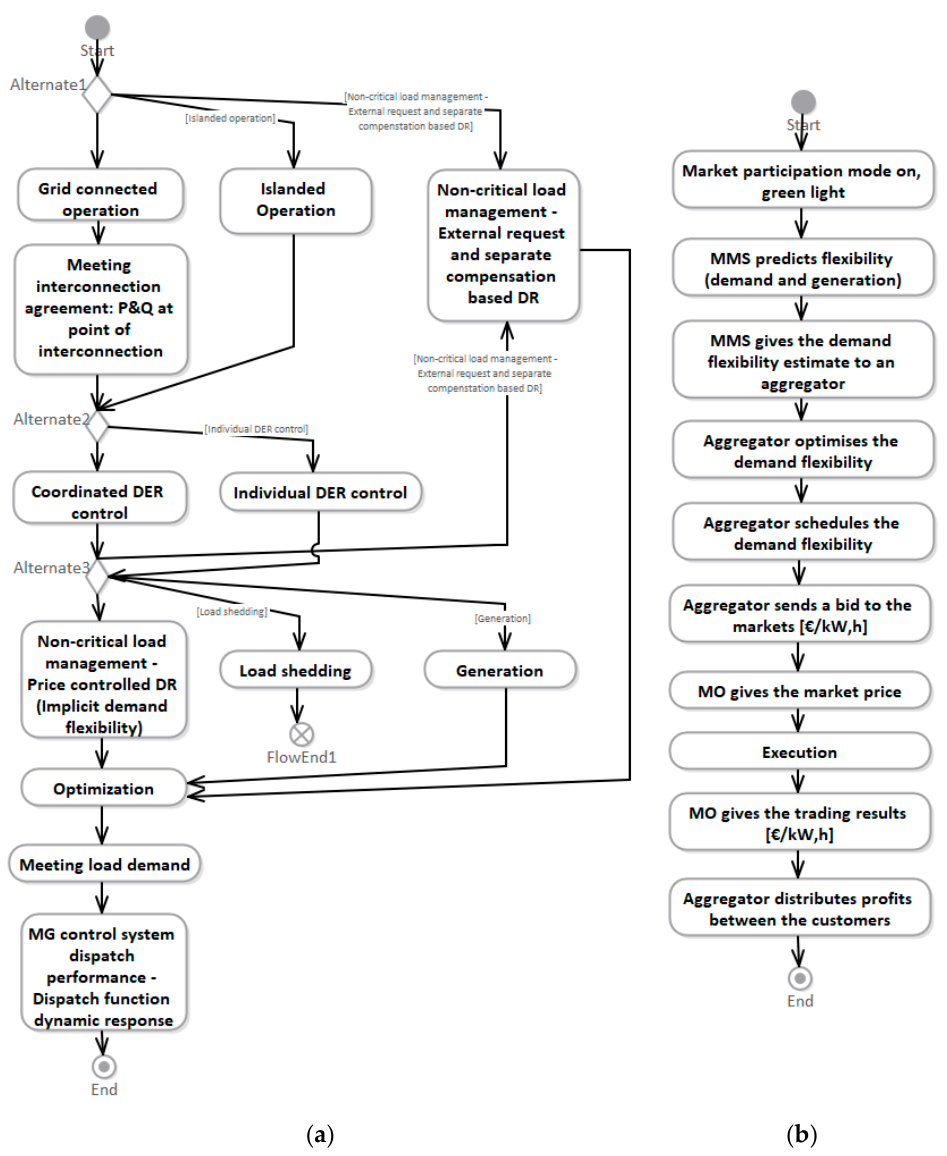
Figure 9. Microgrid energy management system: ( a ) activity diagram of the energy management high-level use case (HL-UC); ( b ) activity diagram of the demand response for ancillary services protection use case (PUC).